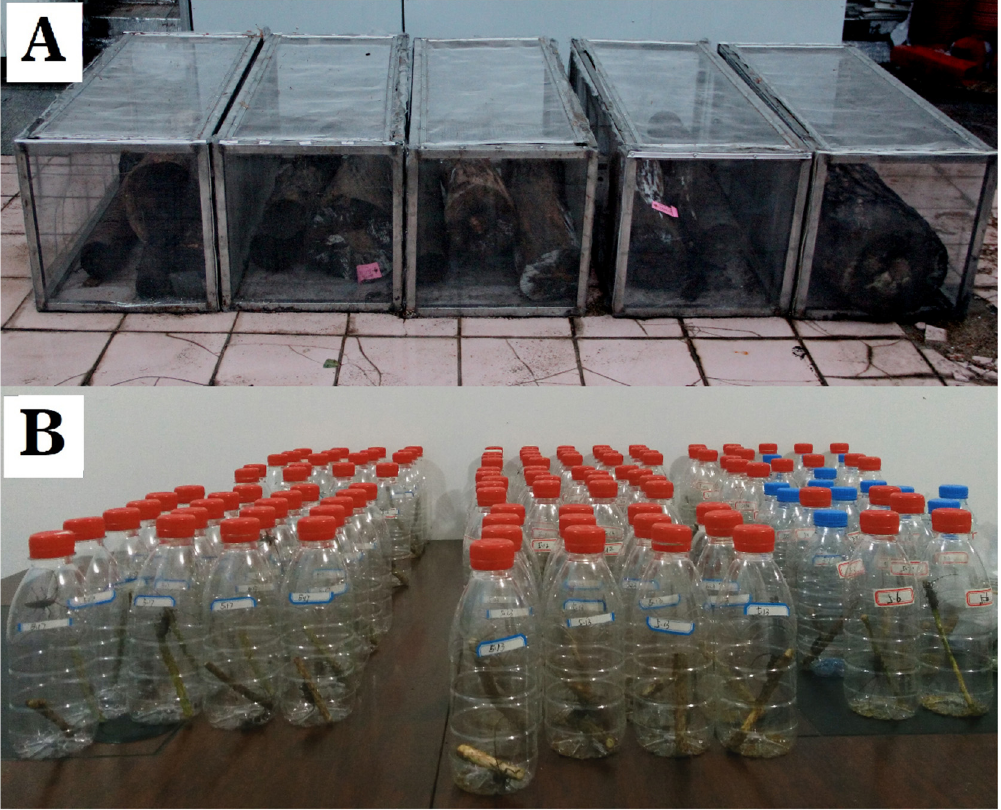
Figure 1. Collection and feeding of Monochamus alternatus. ( A ): Pine trees were cut into logs and maintained in outdoor insect cages, Monochamus alternatus were collected daily (every 8 h) during the period of adult beetle emergence. ( B ): The collected Monochamus alternatus were put into small bottles and fed with fresh twigs of pine.